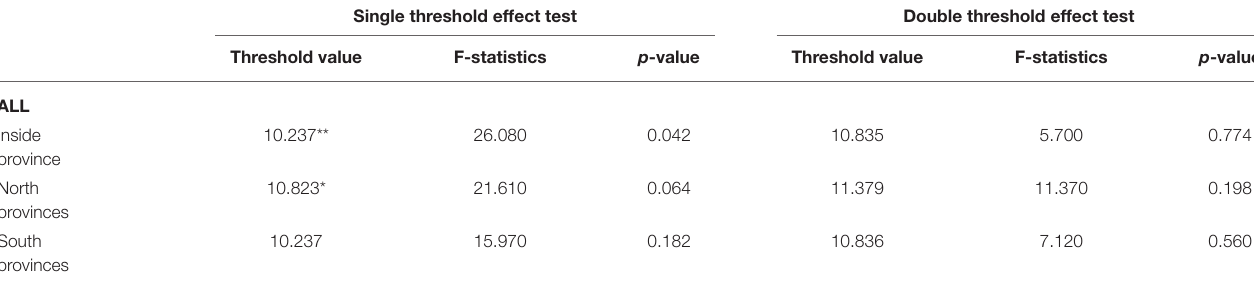
TABLE 6 | Robustness check.